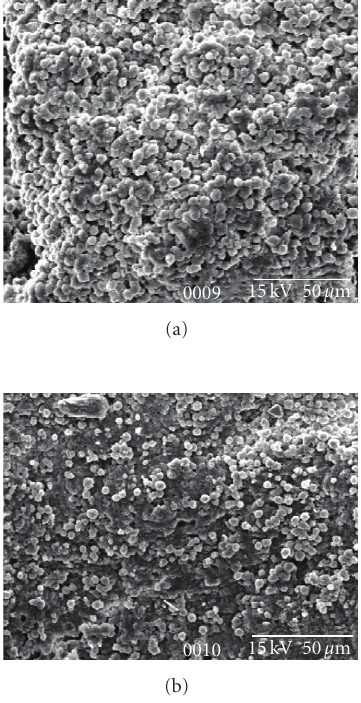
Figure 5: (a) Scanning electron microscopy of normal bone marrow. (b) Scanning electron microscopy of Aplastic bone marrow exhibit an overall scanty and degenerative marrow and other cellular components compared to the normal